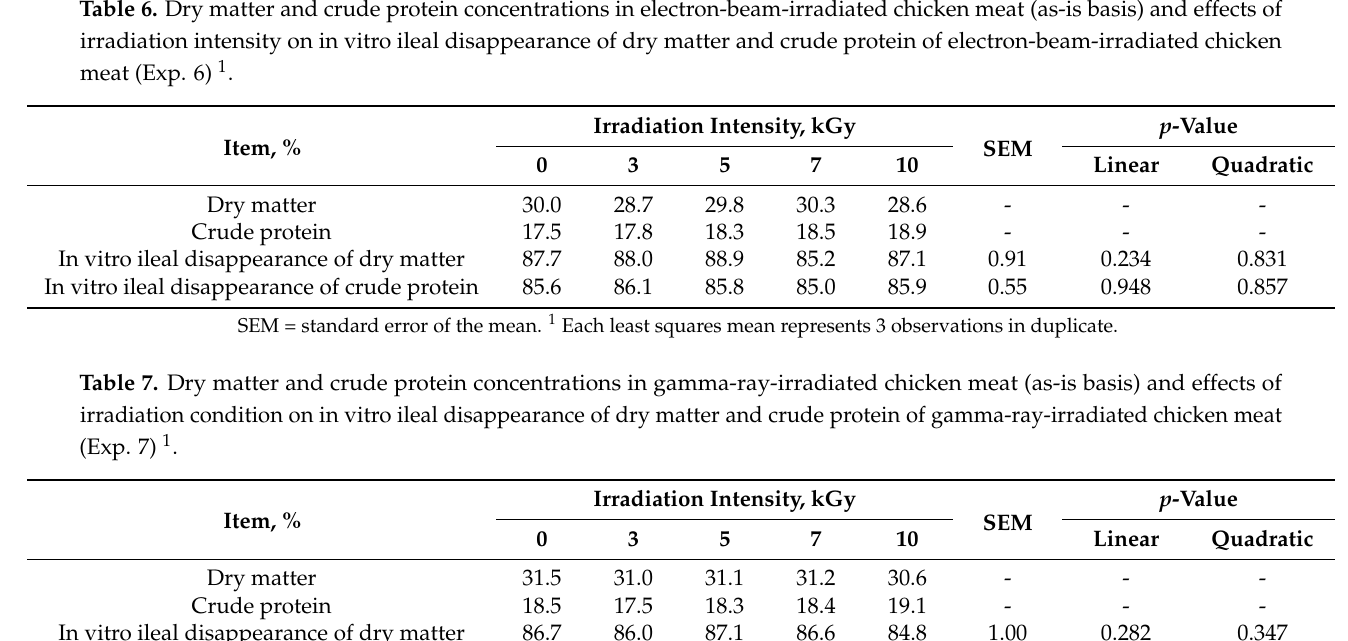
SEM = standard error of the mean. 1 Each least squares mean represents 3 observations in